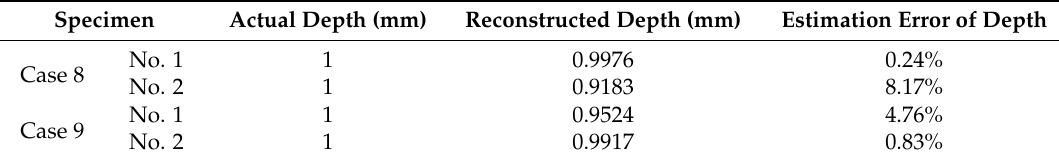
Table 5. The depth evaluations of Case 8 and Case 9.